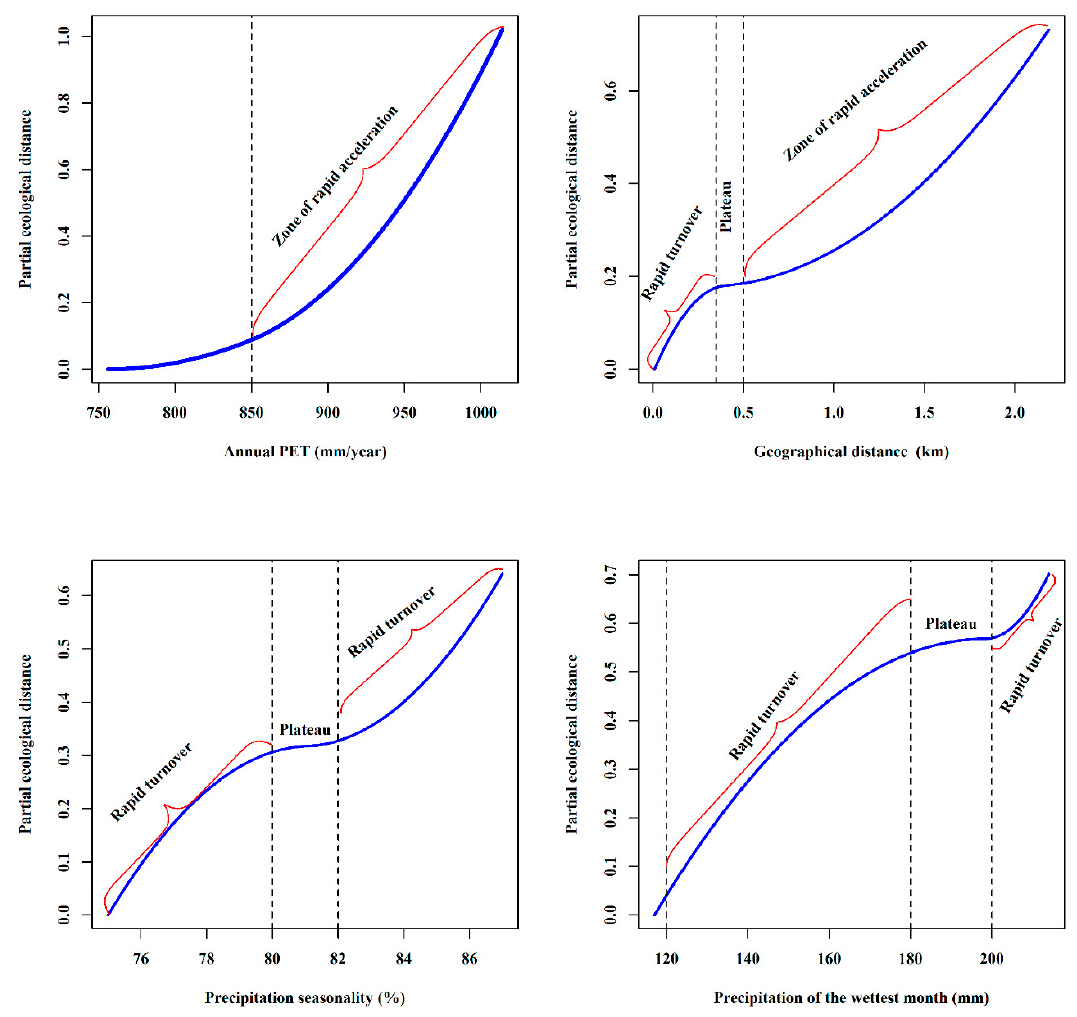
Figure 4. Generalised Dissimilarity Modelling (GDM)-fitted I-splines (partial regression fits) for variables significantly associated with SIE community composition. The maximum height reached by each curve indicates the total amount of turnover associated with that variable, holding all other variables constant. The shape of each function indicates the variation of the turnover rate along the gradient. PET: Annual potential evapotranspiration.